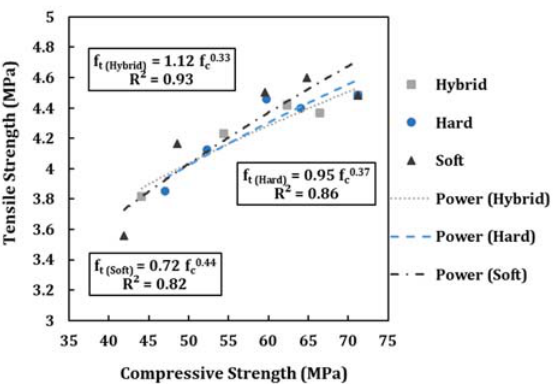
Figure 10. The relation between the tensile strength and compressive strength of concrete containing different percentages and types of BPW.